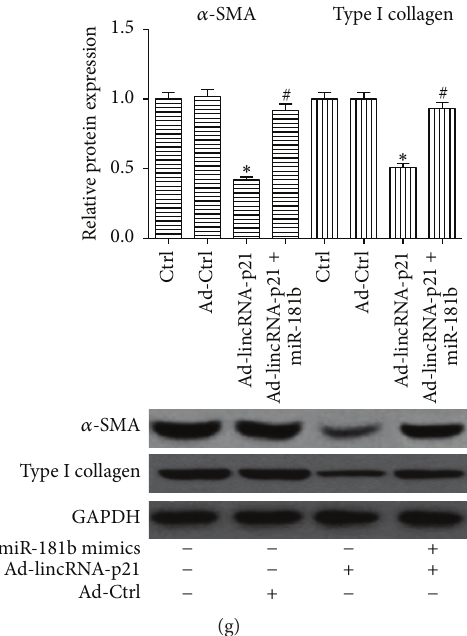
Figure 3: miR-181b is involved in the effects of lincRNA-p21 on PTEN expression and HSC activation. Cells were transduced with Ad- lincRNA-p21 for 48 h and treated with miR-181b mimics for additional 48h. (a) Expressions of miR-21, miR-24, miR-32, miR-93, miR-153, miR-181b, miR-205, and miR-214 were detected in cells transduced with lincRNA-p21. (b) Expression of miR-181b in liver tissues of healthy controls ( 𝑛 = 15 ) and cirrhotic patients ( 𝑛 = 15 ). (c) Expression of miR-181b in miR-181b mimics group. (d) lincRNA-p21-induced PTEN was inhibited by miR-181b. (e) The effect of Ad-lincRNA-p21 on cell proliferation was suppressed by miR-181b. (f) The reduced mRNA expressions of 𝛼 -SMA and Col1A1 by Ad-lincRNA-p21 were inhibited by miR-181b. (g) The reduced protein expressions of 𝛼 -SMA and type I collagen by Ad-lincRNA-p21 were inhibited by miR-181b. GAPDH was used as internal control. Each value is the mean ± SD of three experiments. ∗ 𝑃 < 0.05 compared with the control and # 𝑃 < 0.05 compared with Ad-lincRNA-p21